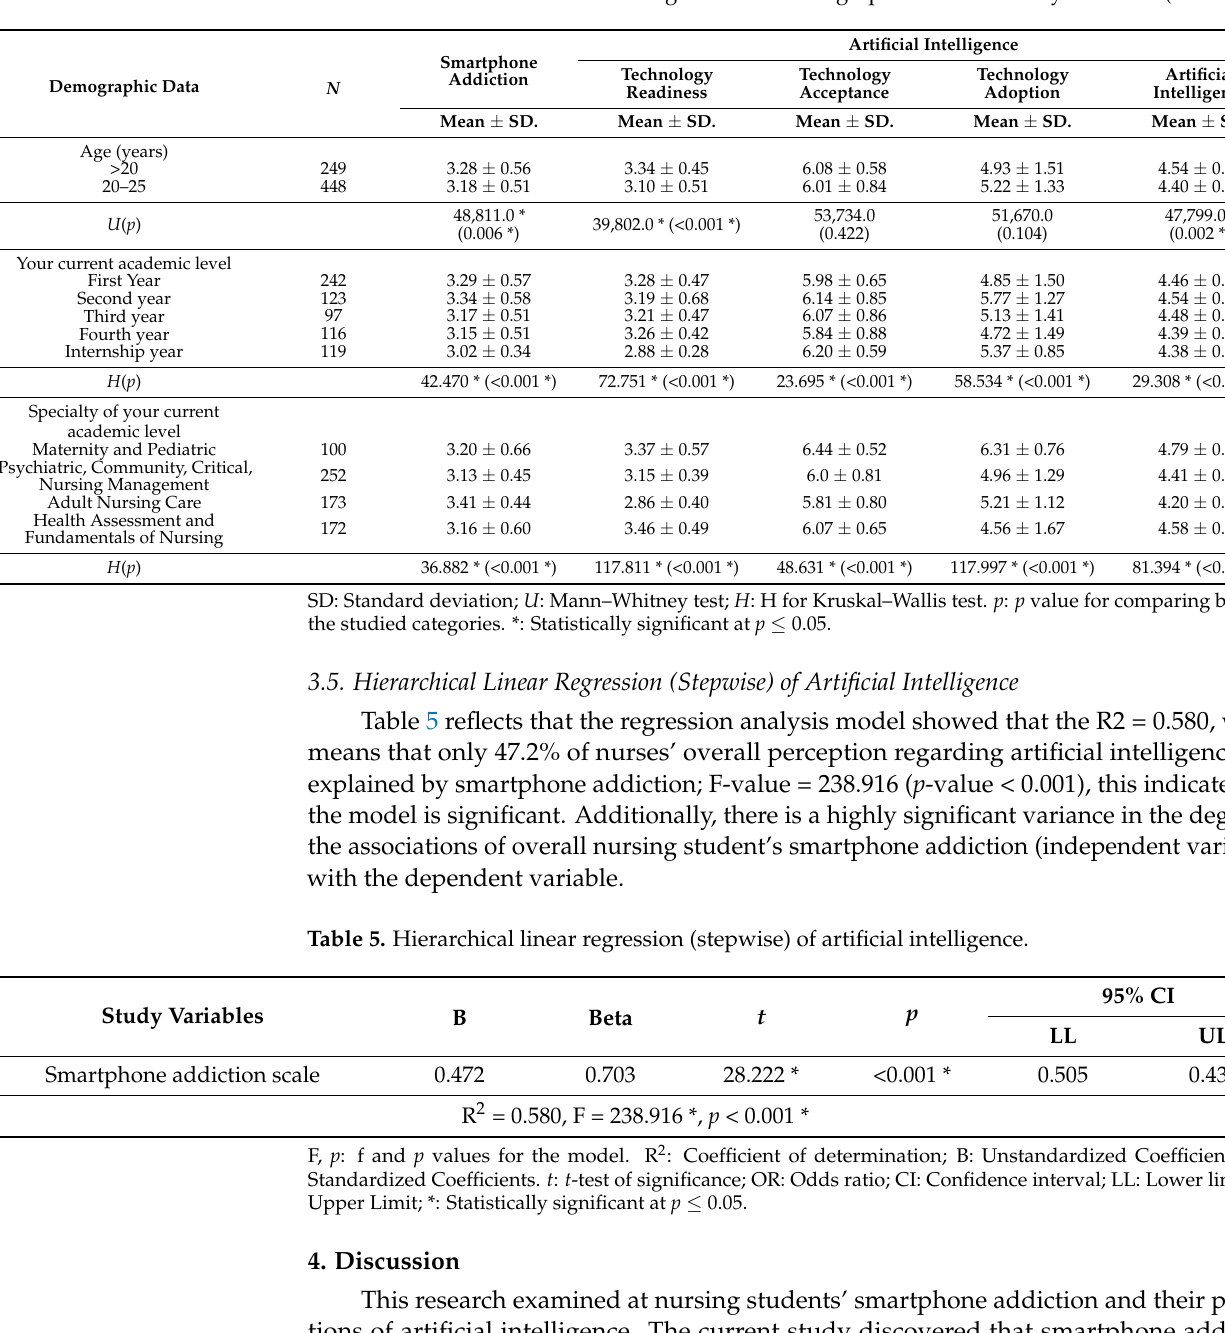
Table 4. Correlation between nursing students’ demographics and the study variables ( n = 697).